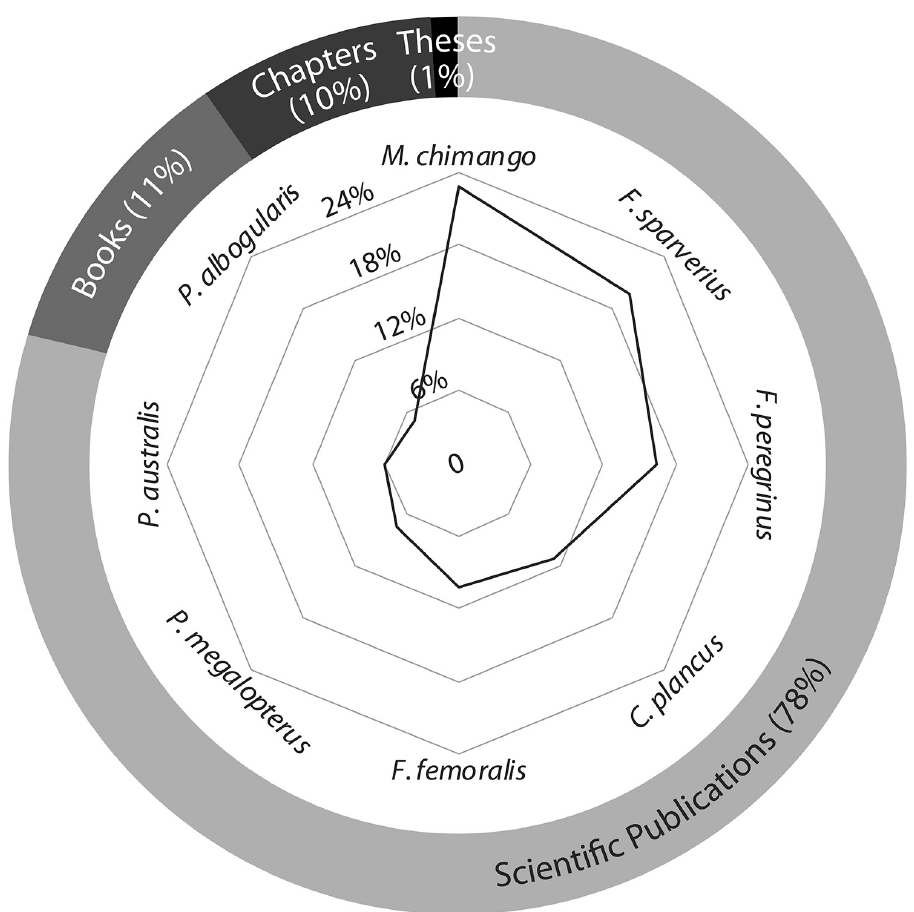
Figure 4. Relative bibliographic importance according to circulation medium and researched species.